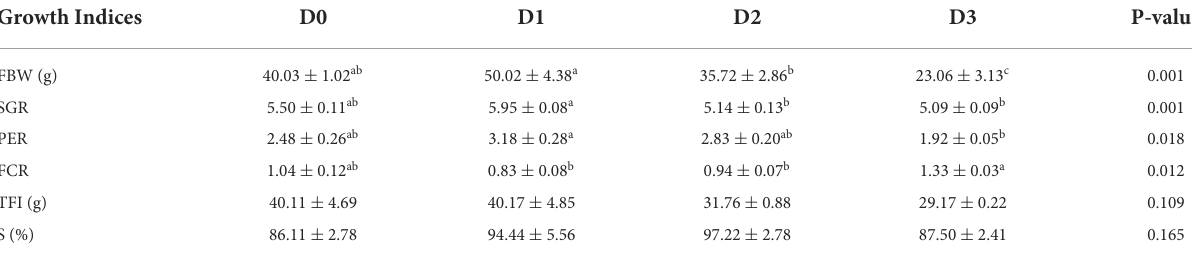
TABLE 4 Growth performance indices, survival, feed efficiency, and nutrient retention of seawater-tolerant tilapia fed with diets supplemented with T. weissflogii paste. Growth